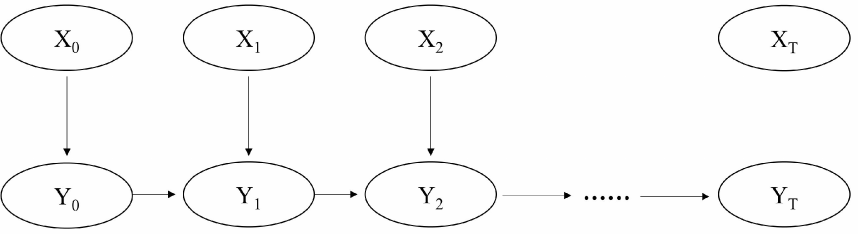
Figure 3. Dynamic Bayesian network. Reprinted with permission from Ref. [35]. 2018,